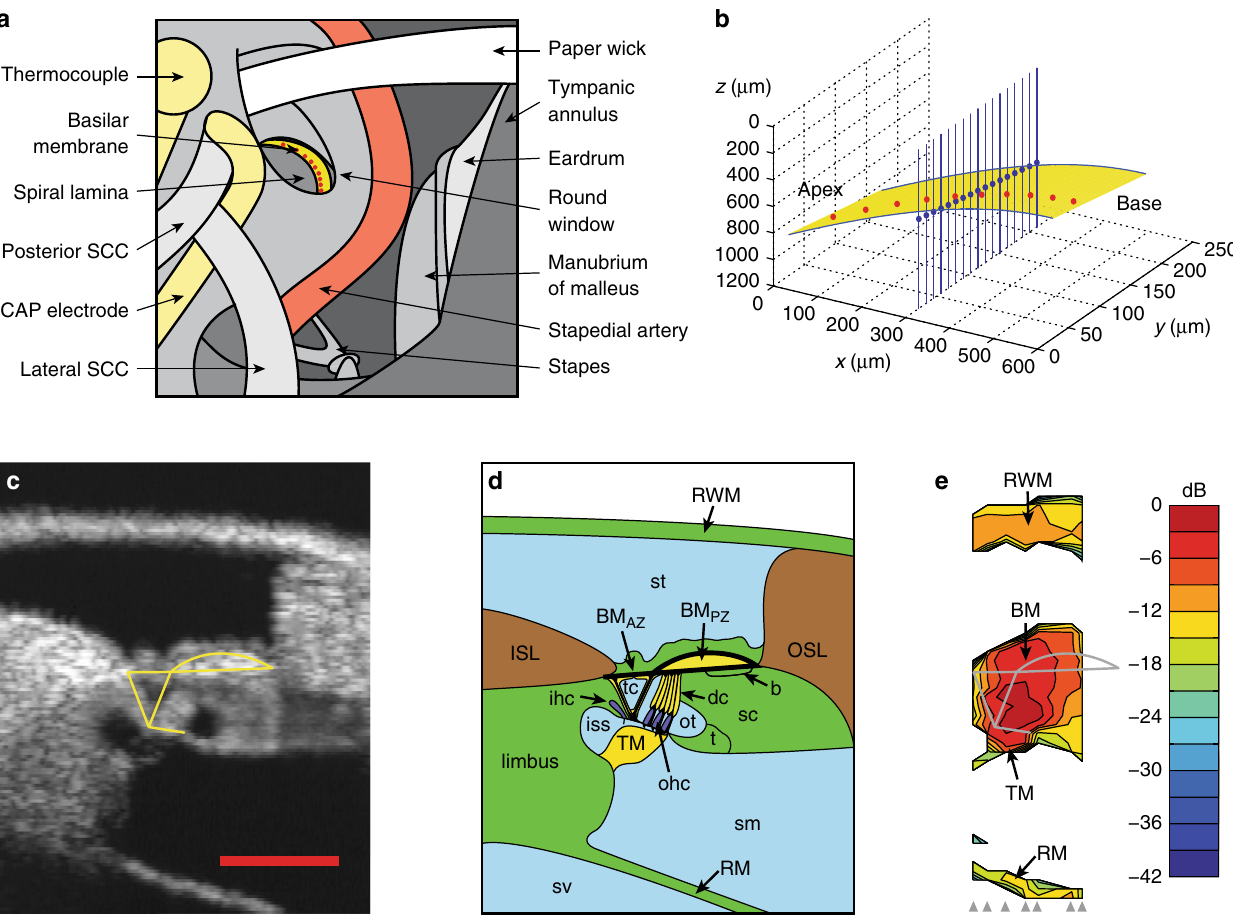
Fig. 1 In vivo imaging and anatomy of the gerbil cochlear partition. a Experimental approach to the middle-ear, basilar membrane, and underlying structures of the cochlear partition in the round window region of the gerbil cochlea. b Vibration measurements are made by aligning the OCT beam with discrete points spanning the length (red dots) and width (blue dots) of the twisting, tilting, and spiraling cochlear partition (yellow). The measurement technique is sensitive only to vibration components that align with the near-vertical optical axis of each OCT beam. c OCT re fl ectance image (grayscale), with structural framework of Corti ’ s organ (yellow) superimposed for reference (cf. d , e ). Scale bar (red), 0.1 mm. d Underlying anatomical structures. The hearing organ ’ s sensory cells are shown in dark blue, with key mechanical support cells and accessory structures in yellow. Thick black lines replicate elements of the main structural framework from c : the framework includes the collagen-rich arcuate and pectinate zones of the BM, the tubulin-rich inner and outer pillar cells that form the main (inner, triangular) tunnel of Corti, and the actin-rich reticular lamina (including the cuticular plates of the sensory inner and outer hair cells). e Map of vibration magnitudes evoked by a multi-tone stimulus at 70 dB SPL. Magnitudes are expressed on a logarithmic color scale, in decibels (dB) relative to the maximum root-mean-square magnitude of 10 nm. Measurement beam ordinates are indicated at the base of the map using gray arrowheads. b Boettcher ’ s cells, BM AZ/PZ basilar membrane arcuate and pectinate zones, CAP compound action potential, dc Deiters ’ cells, ISL inner (primary, osseus) spiral lamina, ihc inner hair cell, iss inner spiral sulcus, ohc outer hair cells, OSL outer (secondary) spiral lamina and ligament, ot outer tunnel of Corti, RM Reissner ’ s membrane, RWM round window membrane, sc support cells, SCC semicircular canal, sm scala media, st scala tympani, sv scala vestibuli, t tectal cells, tc tunnel of Corti (inner). Preparation RG16760, CF 40